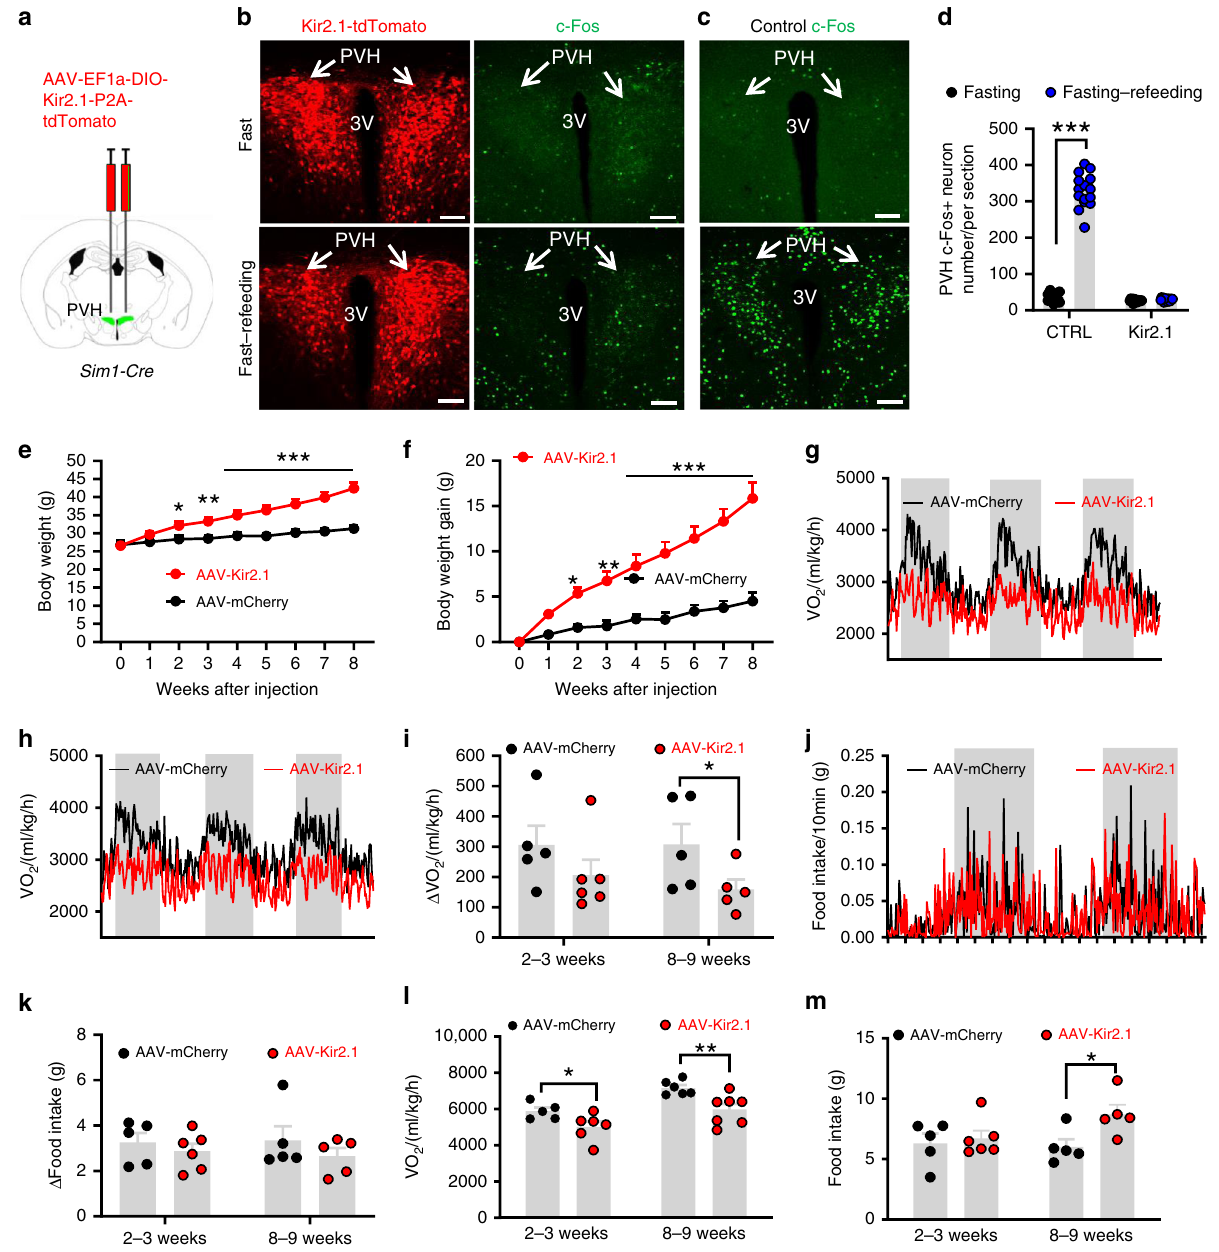
Fig. 2 Clamping PVH neuron activity at a low lever disrupted diurnal metabolism and caused obesity. Sim1-Cre mice (8 – 10 weeks old) received injections of AAV-FLEX-mCherry or AAV-DIO-EF1a-Kir2.1-P2A-dTomato vectors to bilateral PVH and used for studies. a Diagram showing injections of viral vectors to the PVH of Sim1-Cre mice. b – d Expression of dTomato in the PVH after the Kir2.1 virus expression ( b , left panels), and representative expression of c-Fos expression in the PVH after overnight fasting alone (top panels) or overnight fast with 2 h refeeding (bottom panels) in Kir2.1 mice ( b , right panels) and control ( c ). At least three mice with fi ve sections containing the PVH were used for counting the number of c-Fos in the PVH. Arrows point to the PVH proper. d Comparison of average number of c-Fos positive neurons in the PVH (two-way ANOVA, n = 15 each, F (1, 56) = 544.4, *** p < 0.0001, control fasting vs fasting – refeeding; and p = 0.9909 Kir2.1 fasting vs fasting – refeeding). e – m Weekly body weight ( e , two-way ANOVA, n = 5 for control and 6 for Kir2.1, F (8, 171) = 4.022, *** p < 0.0001, body weight at 8-9 weeks after injection between Control and Kir2.1) and weekly net body gain ( f , two-way ANOVA, n = 5 for control and 6 for Kir2.1, F (8, 171) = 6.401, *** p < 0.0001, body weight at 8-9 weeks after injection between Control and Kir2.1) were followed, and real time traces showing energy expenditure measurements at 2 – 3 weeks ( g ) and 8 – 9 weeks ( h ), and feeding 2 – 3 weeks ( j ) after viral delivery; comparison in the difference of energy expenditure ( i , two-way ANOVA, n = 5 for Control and 6 for Kir2.1, F (1, 17) = 1.138, * p = 0.0378, 8-9 weeks after injection between Control and Kir2.1) and feeding ( k ) between day and night both 2 – 3 and 8 – 9 weeks after viral delivery; daily energy expenditure ( l , two-way ANOVA, n = 5 for Control and 6 for Kir2.1, F (1, 20) = 25.99, * p = 0.026 2 – 3 weeks after injection and ** p = 0.0059 for 8 – 9 weeks after injection between Control and Kir2.1) and feeding ( m , two-way ANOVA, n = 5 for Control and 6 for Kir2.1, F (1, 20) = 3.292, * p < 0.0399, 8-9 weeks after injection control vs Kir2.1) both 2 – 3 and 8 – 9 weeks after viral delivery were shown. All data presented at mean ± SEM. PVH paraventricular hypothalamus, 3V the third ventricle. Scale bar = 200 µ M. Source data are provided as a Source Data fi